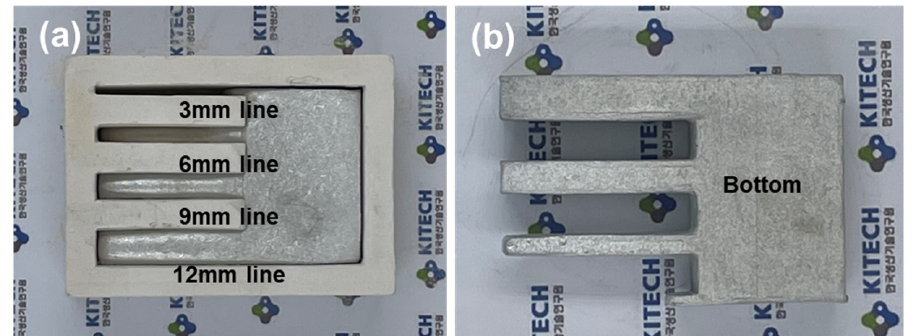
Figure 9. Hand-shaped mold for checking flowability by process ( a ) mold and casting with molten metal poured ( b ) bottom surface of hand-shaped aluminum casting.